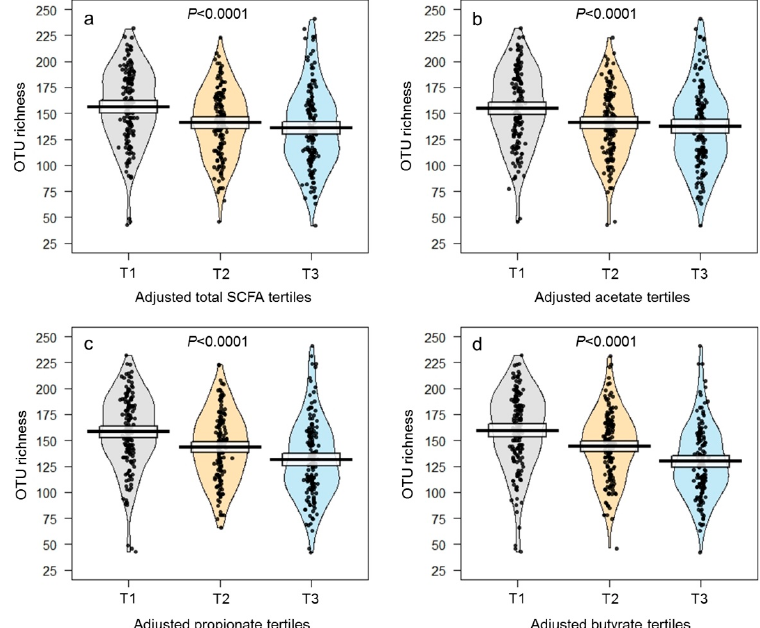
Figure 1. Distribution of gut microbiota diversity according to tertiles (T1: Low, T2: Intermediate, T3: High) of multivariable-adjusted fecal SCFA concentrations: ( a ) Total SCFAs; ( b ) acetate; ( c ) propionate; and ( d ) butyrate. SCFA concentrations were adjusted for age, city of origin, caloric intake, physical activity, and fiber intake. The raw data, average, and 95% confidence intervals are shown for each tertile. Table 2. Multivariable-adjusted Pearson correlations between measures of adiposity, cardiometabolic health, gut microbiota diversity, gut permeability, and fecal SCFA levels. Total SCFAs Acetate Propionate Butyrate Isobutyrate OTU Richness